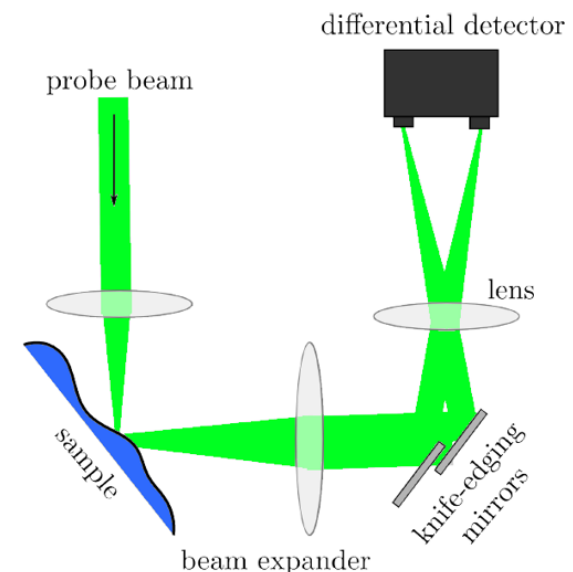
Figure 5. Schematics of the LBD detection setup. A surface deformation, resulting from laser excitation of thermoelastic phenomena, deflects an incident probe beam. The deflection is monitored by a differential photodetector using knife-edging